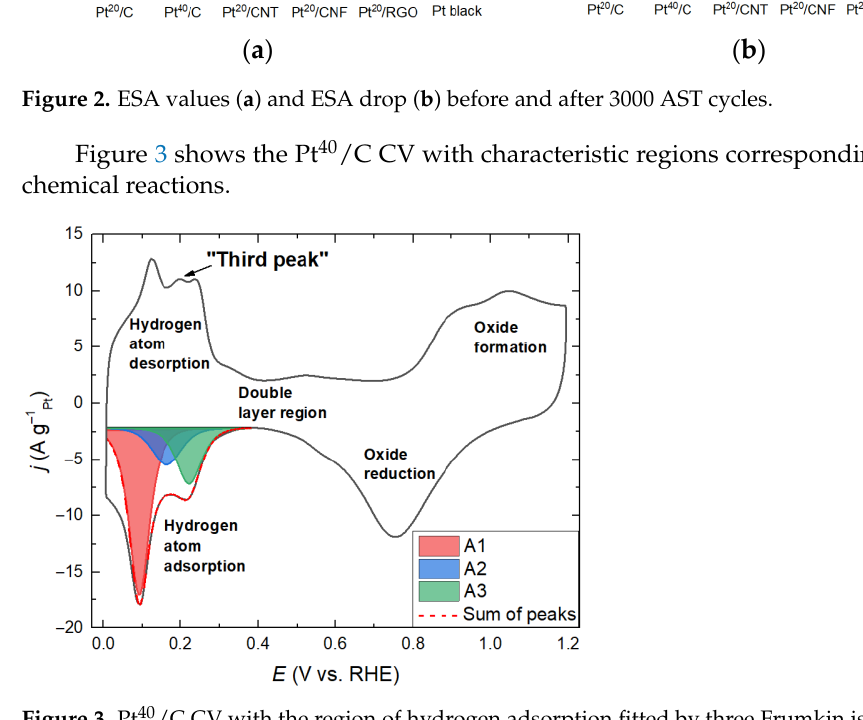
Figure 3. Pt 40 /C CV with the region of hydrogen adsorption fitted by three Frumkin isotherm peaks.